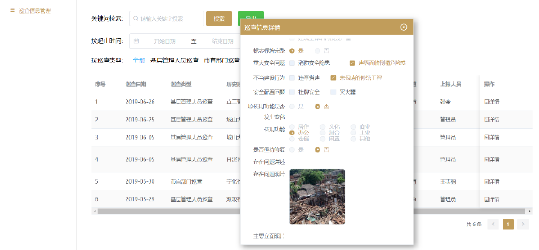
Figure 9. The monitoring information uploaded by the local